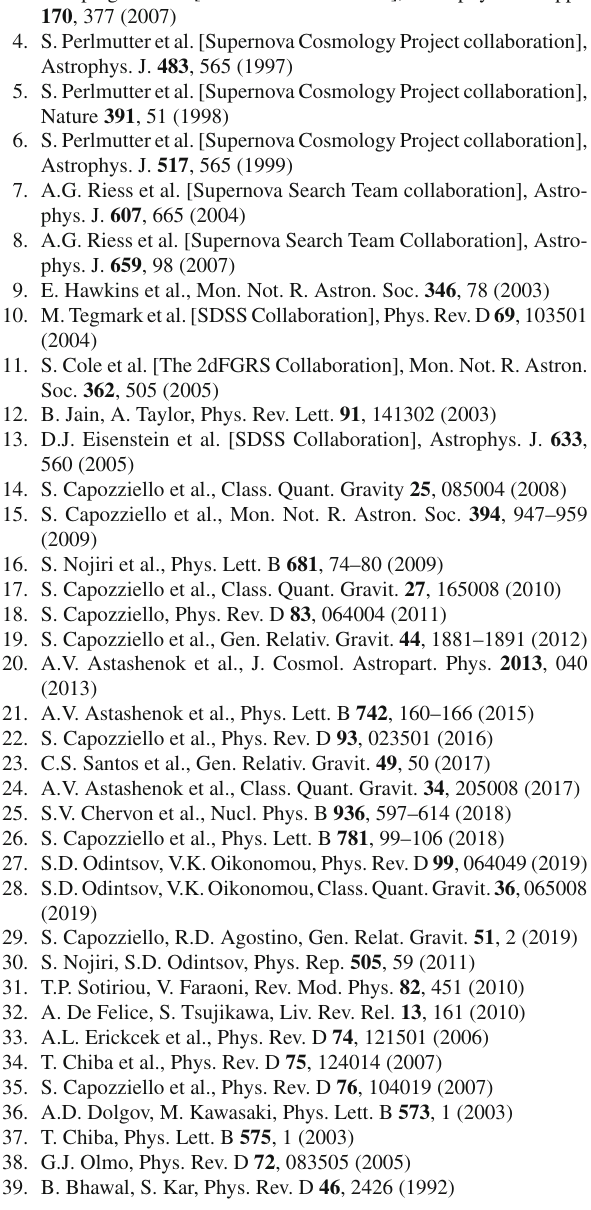
Table 1 Fitting of observed masses and radii with new predictions of radii w.r.t. χ -parameter Objects M / M (cid:9) R (km) Predicted R (km) χ − 1 . 0 − 0 . 5 0.0 0.5 1.0 MSP J0740+6620 2 . 14 + 0 . 20 − – 10 . 36 0 . 18 PSR J1614-2230 1.97 ± 0.04 9.96 ± 0.2 Vela X-1 1.77 ± 0.08 SMC X-4 1.29 ± 0.05 SAX J1808.4-3652 0.9 ± 0.3 Her X-1 0.85 ±